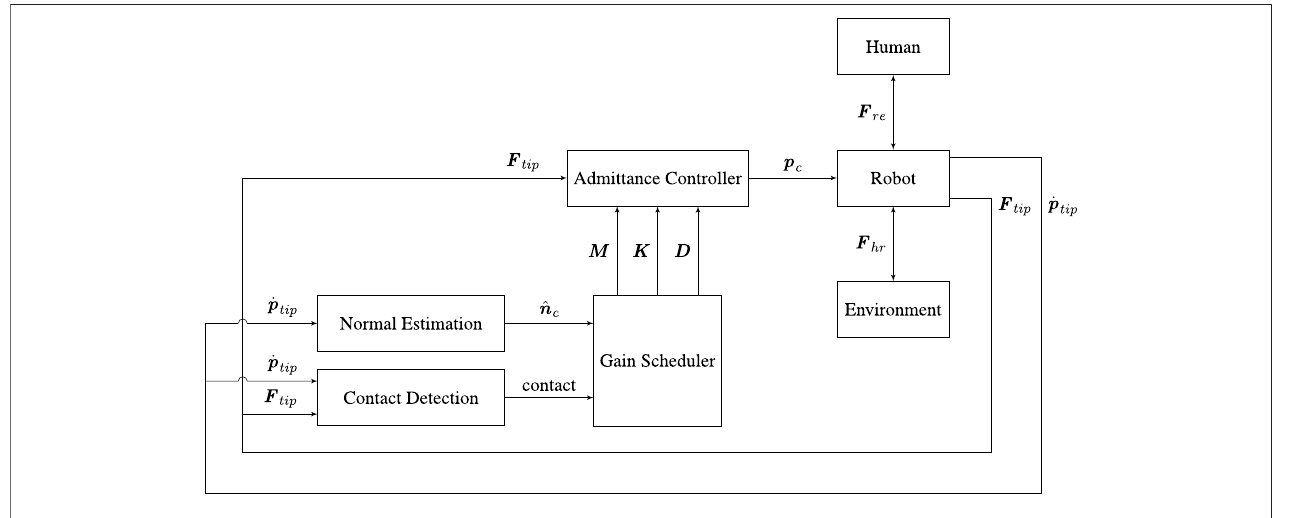
FIGURE 3 | Block diagram of the controller architecture used for task